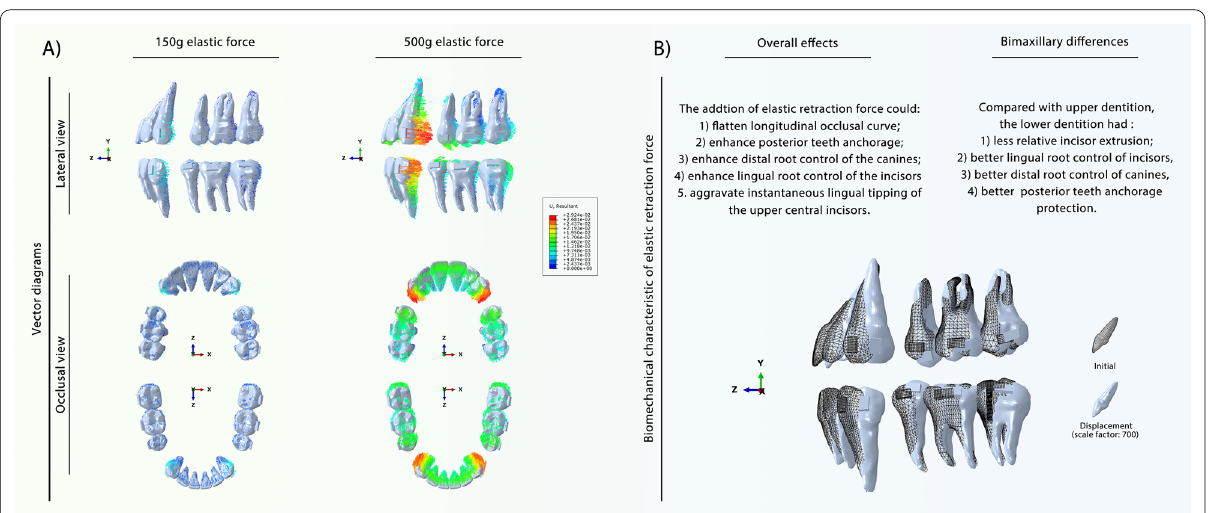
Fig. 4 Biomechanical effects of mere elastic force on the bimaxillary space closure. A Vector diagram reflecting the displacement directions and distances of teeth displacement under 150 g and 500 g elastic forces. B Schematic diagram of different biomechanical effects of elastic force on the upper and lower dentition. The tipping movement and the root control are different concept in this work. The use of elastic force would cause larger instantaneous teeth tipping; the root control was actually enhanced, which means, compared with the moderate group, retracting same distance in direct strong anchorage group could cause less anterior teeth